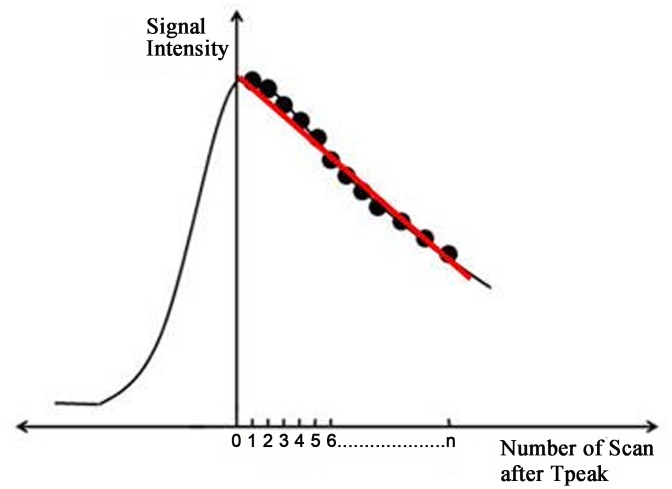
The red curve represents the fitted line of the effluent curve, and the slope of this fitted line is defined as Slopewash.